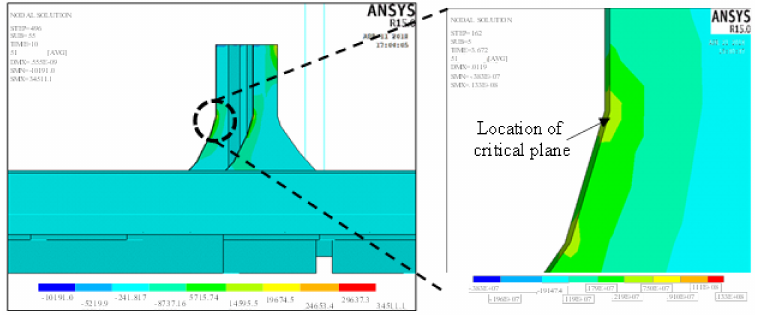
Figure 6. Distribution of major principle stress.